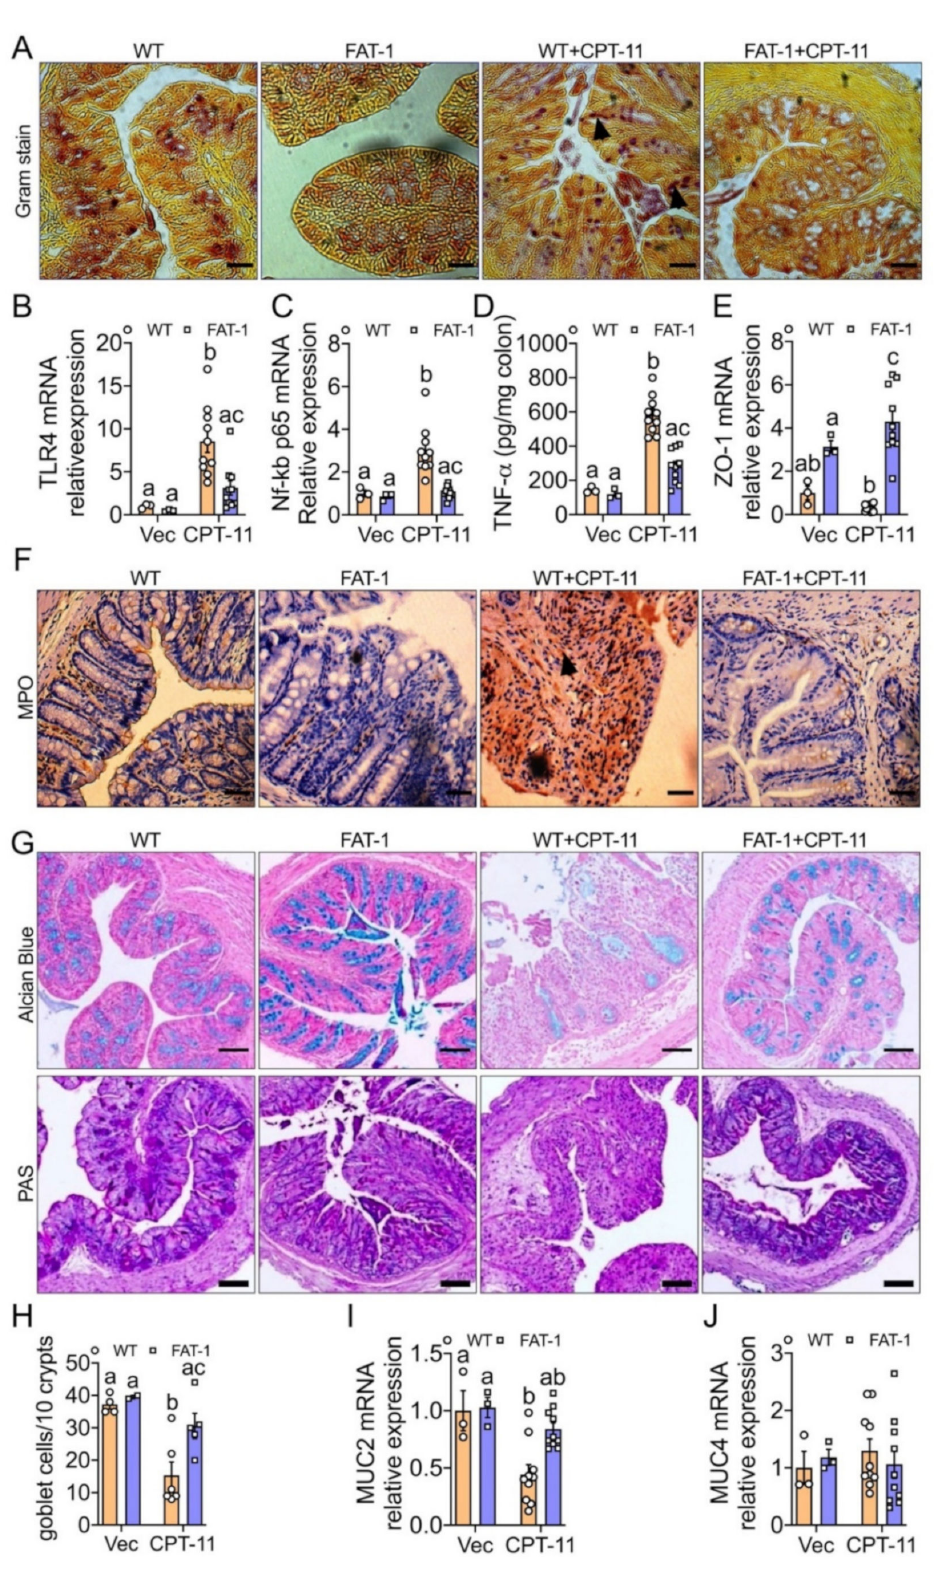
Figure 3. Decreased n-6/n-3 ratio prevents CPT-11-induced intestinal mucosal barrier dysfunction . ( A ) Gram staining was performed on paraffin sections of proximal colonic tissue sections and evaluated by microscopy for the presence of Gram-negative (pink) bacteria (arrowheads). ( B – F ) The markers of colonic mucosal inflammation [toll-like receptor 4 (TLR 4), NF-kB-p65 and TNF- α ],